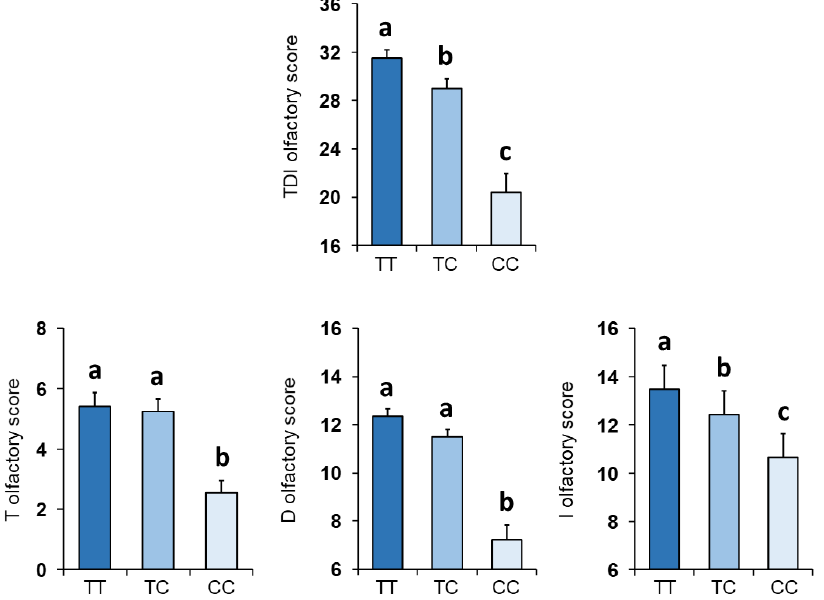
Figure 1. Mean ( ± SEM) values of the threshold (T), discrimination (D) and identification (I) olfactory scores and their summed TDI olfactory scores obtained by subjects according to genotypes of the Kv1.3 locus ( n = 102; 45 TT, 40 TC, 17 CC). Different letters indicate a significant difference ( p < 0.05; Fisher’s LSD test).